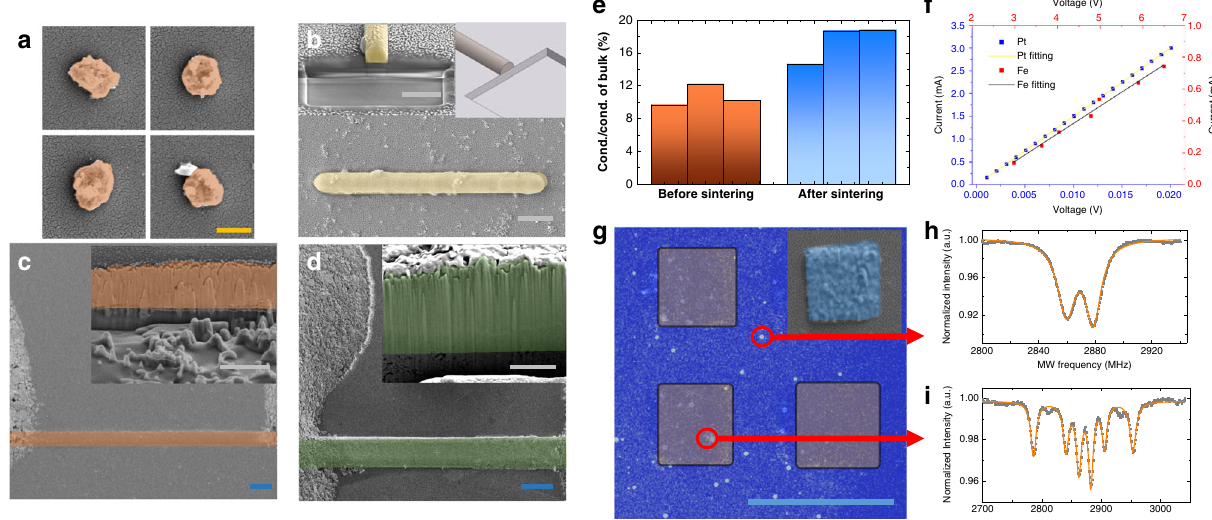
Fig. 3 Physical properties of the deposited structures. a , b SEM images show the spatial resolution reached by the LIMD method in depositing platinum dots a and iron oxide nano-wire b on glass slides. The schematic drawing of the deposition and the SEM image of cross-section view are shown as the inserts in b . c , d SEM images of the surface view and cross-section view (inserts) of platinum deposition c and iron oxide deposition d on glass slides. e The conductivity of platinum structures made before (orange) and after (blue) laser sintering. f The I – V curves measured for platinum (blue) and iron oxide (red) samples. g The fl uorescence image from the confocal microscopy scan and the SEM image (insert) of nickel depositions on a glass slide. h , i the ESR spectra measured with NV centres in diamond in the middle point of the four nickel pads h and on top of one Nickel pad i . The grey scale bars represent 2 μ m, the blue ones represent 50 μ m, the yellow one represents 500 nm. Experimental details are in Supplementary